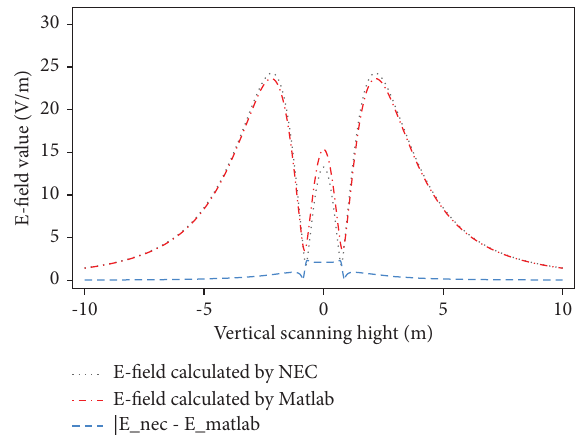
Figure 3: Comparison of E -feld calculated by NEC and MATLAB